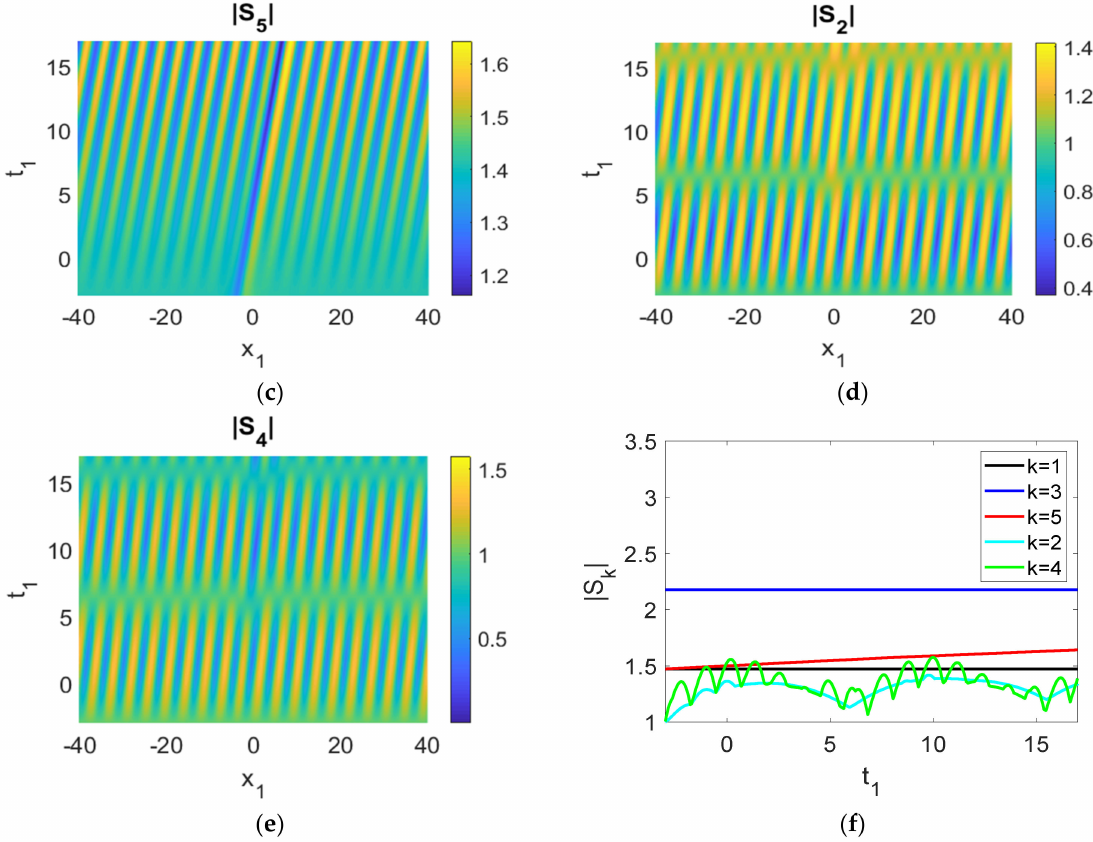
Figure 5. ( a – e ) Control experiment (only | S 2 |, | S 4 | and | S 5 | oscillate, | S 1 |, | S 3 | move as plane wave); ( f ) time history of the moduli of the envelopes, | S k |. Parameters used were c g 1 = 2, c g 3 = 1, c g 5 = 0.5, c g 2 = c g 4 = 0.1, γ 1 = γ 3 = γ 5 a = 0, γ 2 = − 0.1, γ 4 = 0.1, − 0.01, r γ 1 = 1, r 2 = 1, r 3 = 0, q = 1, a 2 = 1, 5 b =